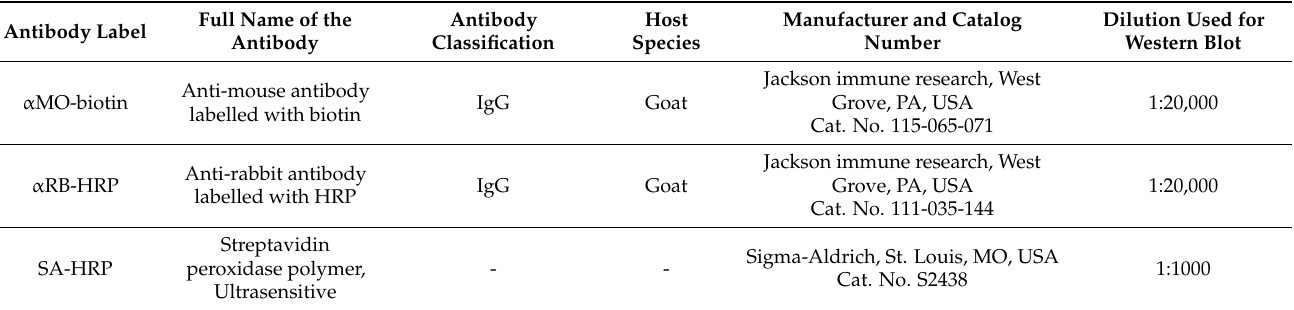
Table 2. List of secondary antibodies and tertiary complex used in Western blot